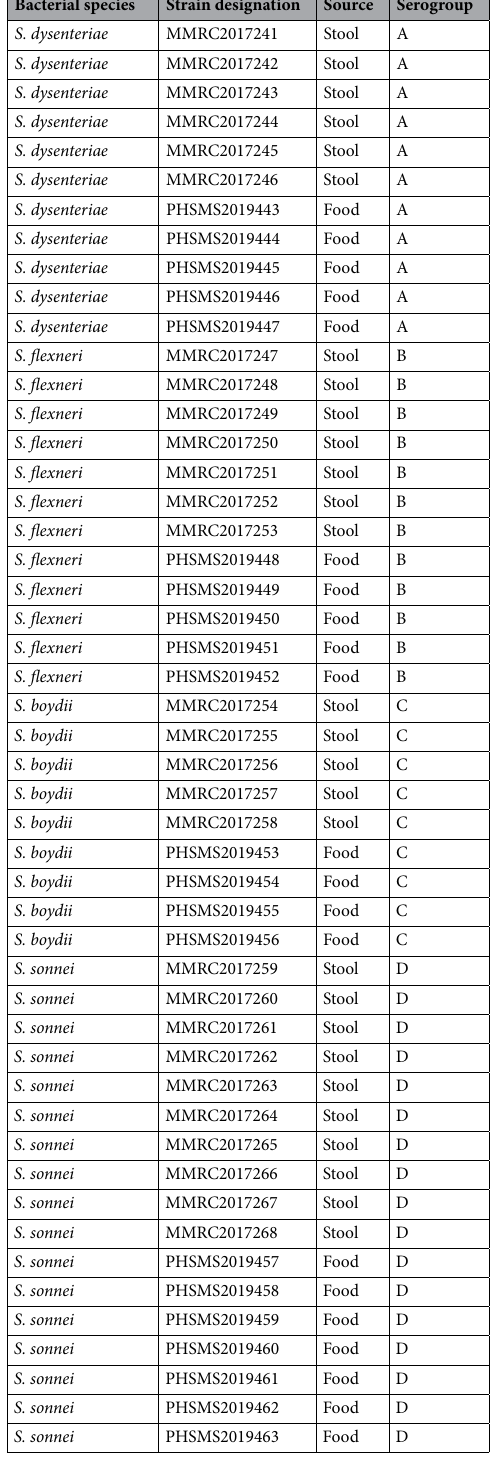
Table 4. Shigella species isolated from clinical and food